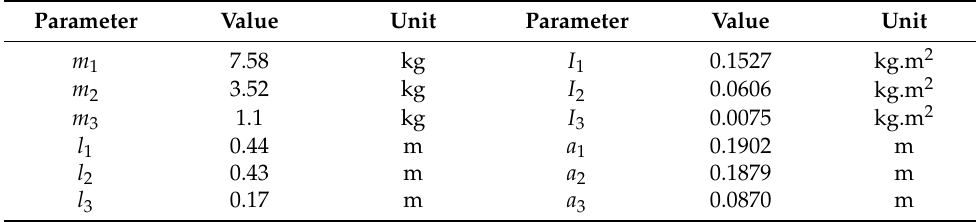
Table 2. Anthropometric data included in the study.